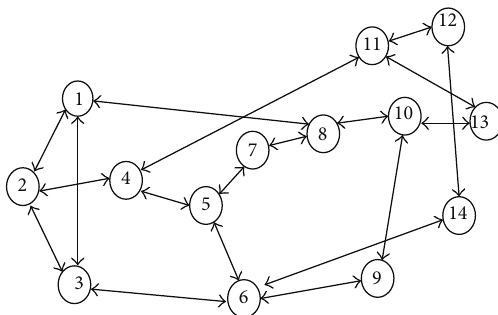
Figure 1: NSFNet network topology (14 nodes 19